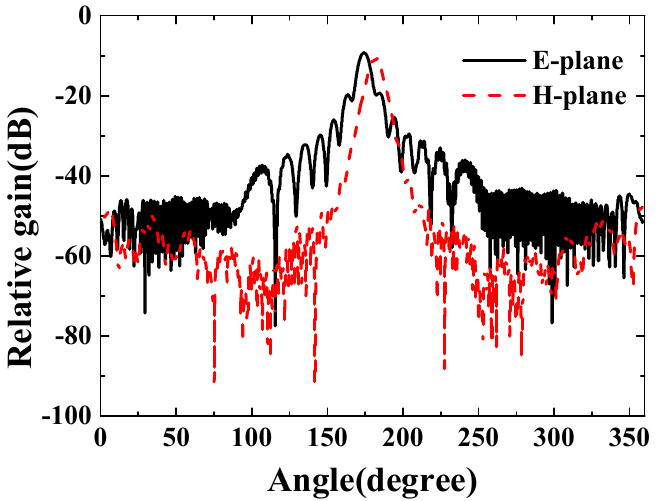
Figure 5. Horn antenna pattern at 39 GHz. (The red line is antenna pattern of H-plane, and the black line is antenna pattern of